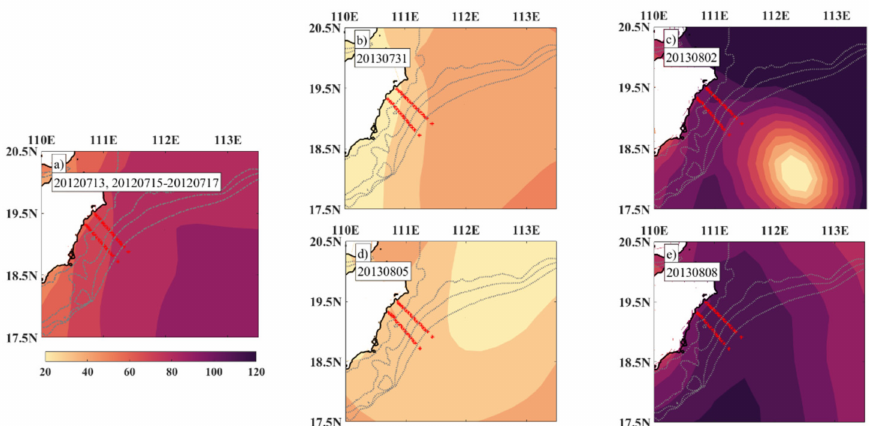
Figure 11. The Ekman layer thickness (m) in the case without the typhoon on 13 and 15–17 July 2012 ( a ) , before the typhoon on 31 July 2013 ( b ), during the typhoon on 2 August 2013 ( c ), and after the typhoon on 5 ( d ) and 8 August 2013 ( e ). Red starts represent observation stations in the two sections H and F. Gray lines represent iso-baths of 50, 100, 150, and 200